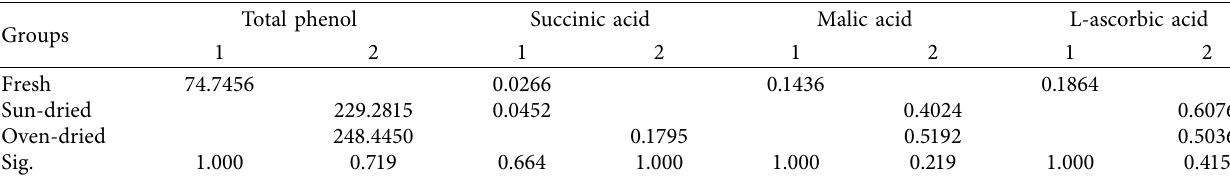
Table 4: Duncan’s test